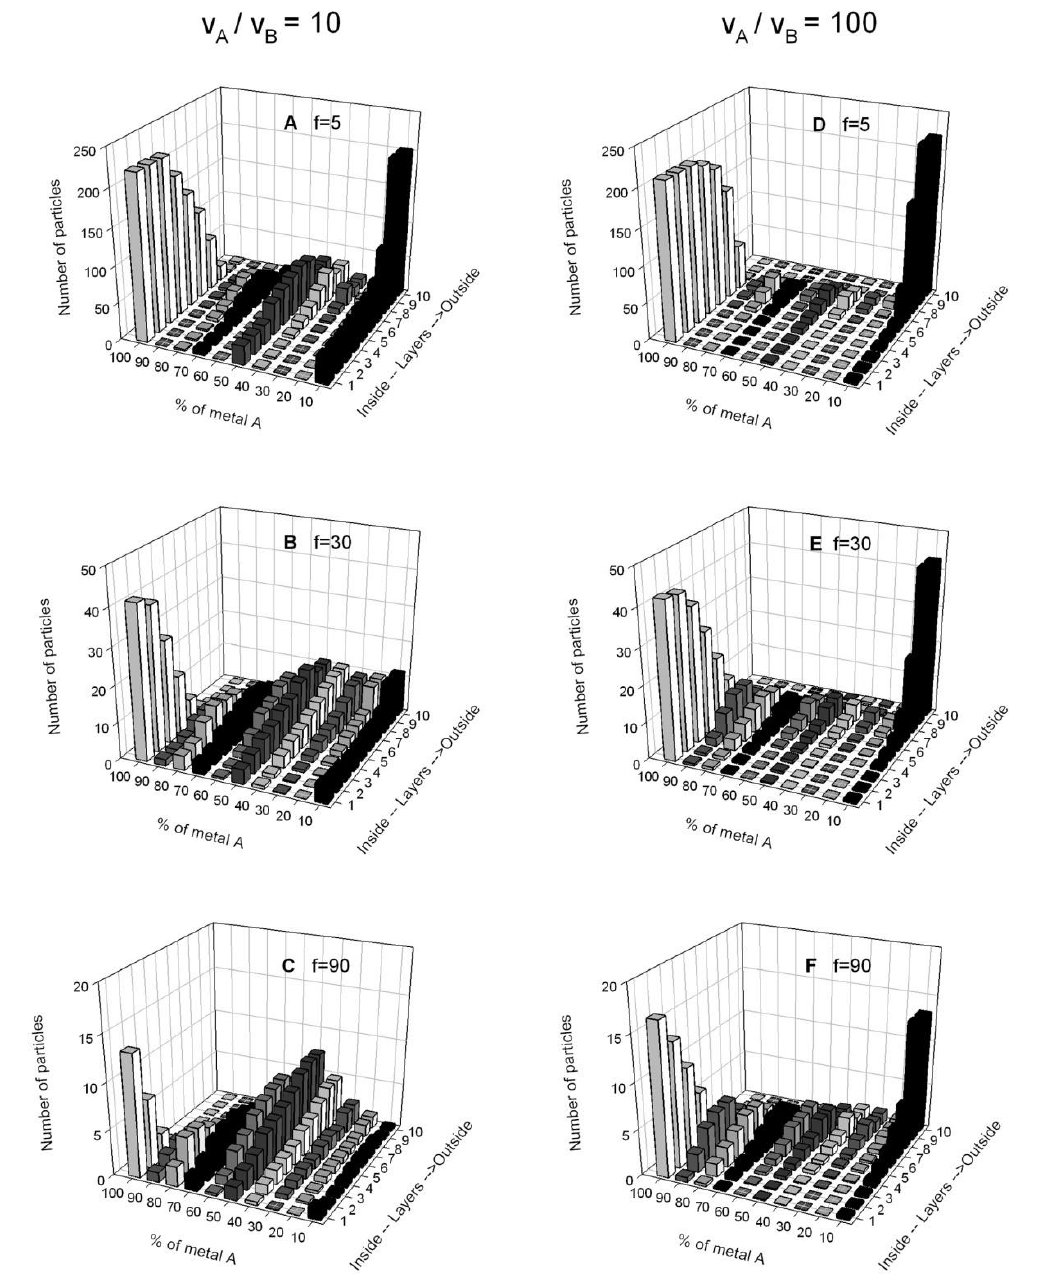
Figure 5. Number of particles versus the percentage of one of the products ( AM ), from the nanoparticle core to the outside (layer by layer) for different film flexibilities, and keeping the reduction rate ratio constant. Left column shows results using v column results using v /v = 100. Synthesis conditions: reactant concentration A, B  c  =  c  = 4, n* = 1, no restriction by droplet size. ( A ) v A B k = 1; ( B ) v /v = 10, flexible film f = 30, k ex A B 90, k = 15; ( D ) v /v = 100, rigid film f = 5, k ex A B k = 5; ( F ) v /v = 100, very flexible film f = 90, k ex A B